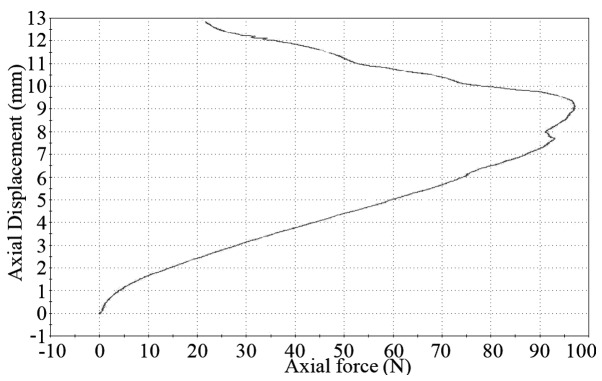
Stress-strain curve of a typical tendon mechanical testing.